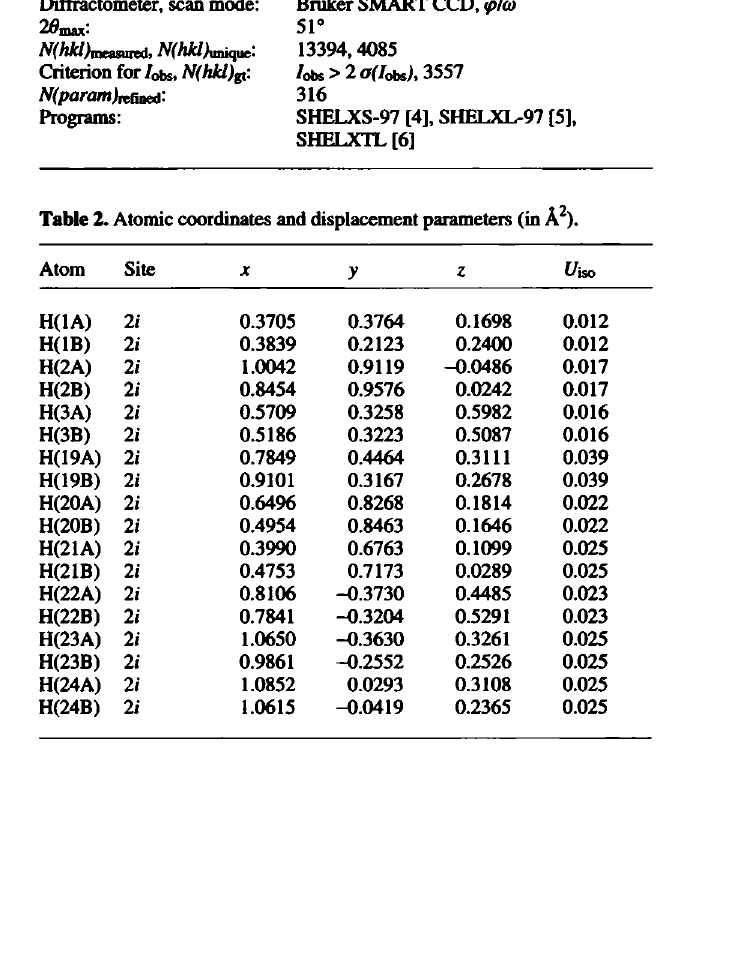
Table 1. Data collection and handling.